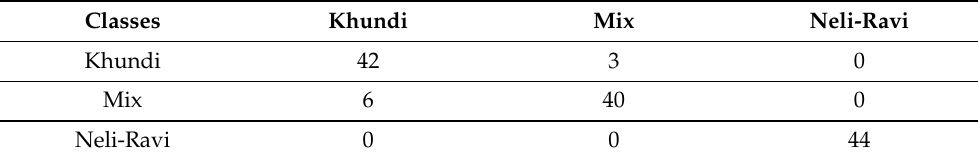
Table 10. Confusion matrix obtained using SVM on 70–30